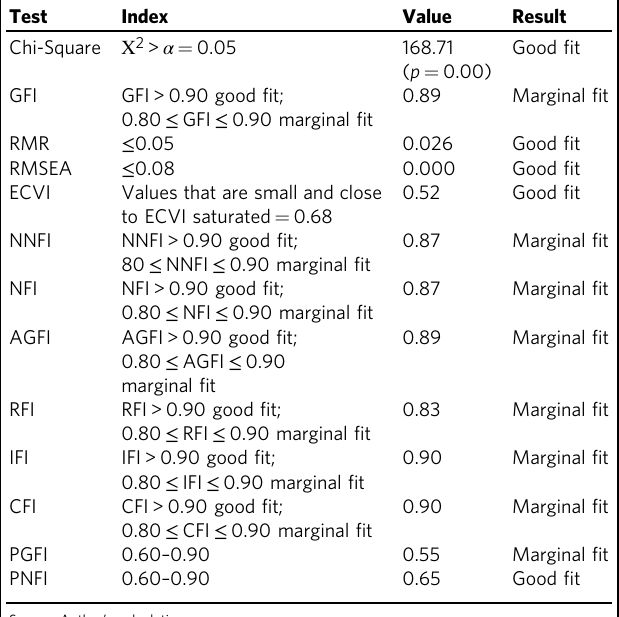
Table 4 The goodness of fi t absolute fi t measures.